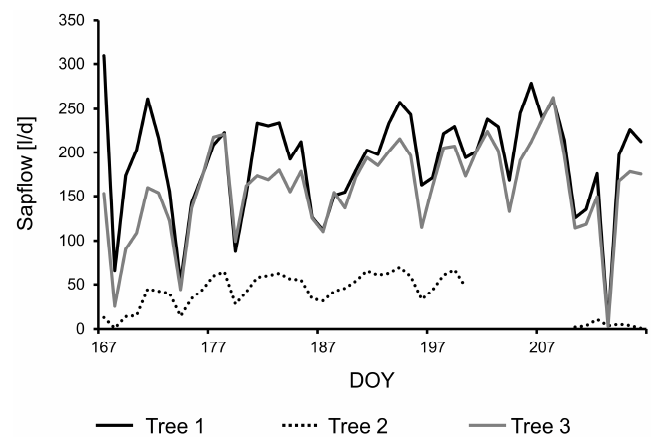
Figure 4. Daily sapflow (L/d) of the three sensor trees from 15 June (DOY 167) to 3 August (DOY 216). DOY refers to n th day of the year.